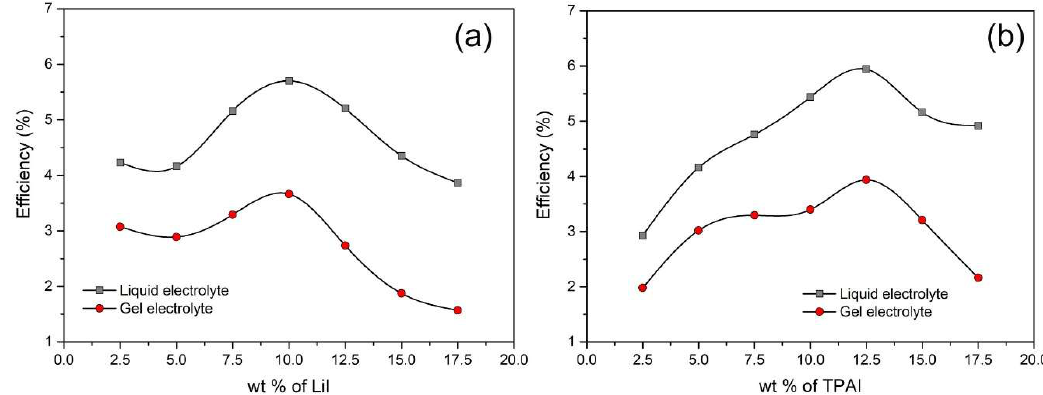
Figure 9. Comparison in the efficiency of the ( a ) liquid electrolyte and ( b ) quasi-solid electrolyte. Table 2. JV parameters of phthaloyl starch and the HEC based electrolyte. Sample